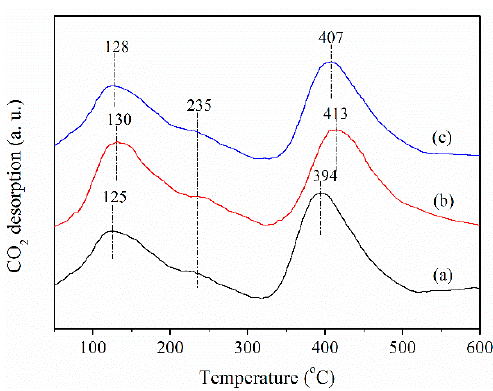
Figure 6. CO 2 -TPD images of (a) 0.005BiOCl/MnMgAlO, (b) 0.01BiOCl/MnMgAlO and (c) 0.015BiOCl/MnMgAlO. Table 2. Basicity of different catalysts.